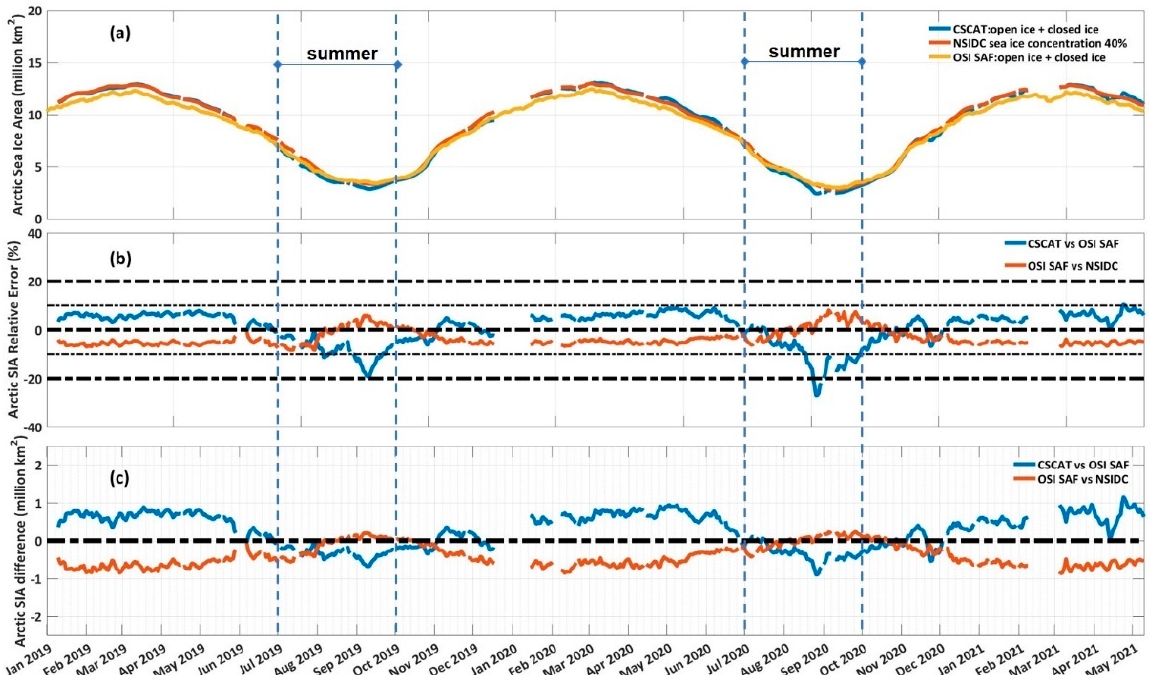
Figure 12. The Arctic results from 1 January 2019 through 10 May 2021 ( a ) daily sea ice area for CSCAT (blue line), NSIDC 40% ice extent (red line) and OSI SAF sea ice edge product (yellow line), respectively, ( b ) sea ice area relative error and ( c ) sea ice area difference between CSCAT and OSI SAF sea ice edge product (blue line), between OSI SAF sea ice edge product and NSIDC 40% ice extent (red line), respectively.